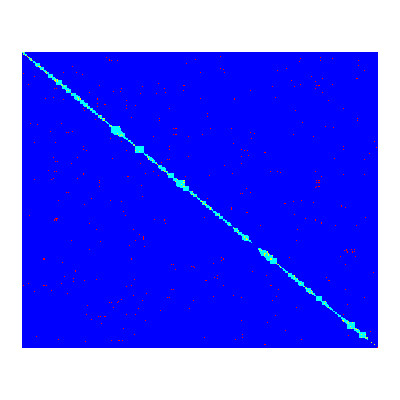
Cluster-matrix. The whole matrix was divided into nine parts. This is a visualisation of the first sector ranging from vertex 1 to 918. True positives and true negatives are coloured in cyan and dark blue, false positives and false negatives in yellow and red, respectively.